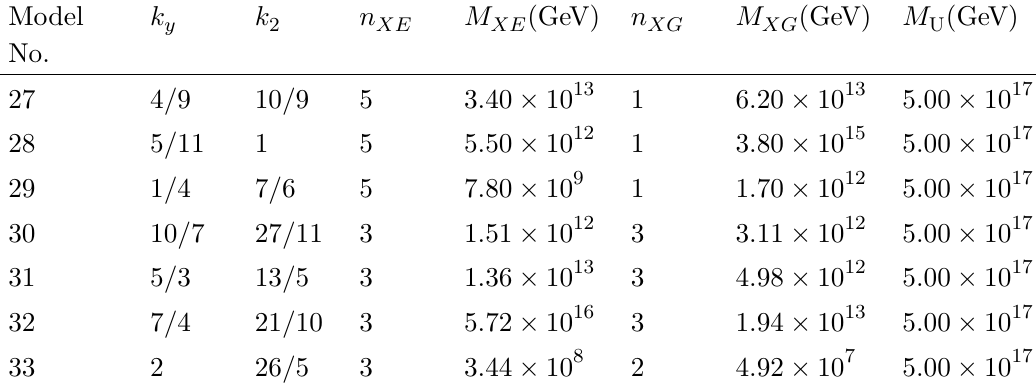
Table 7 . String-scale gauge coupling relations achieved by adding vector-like particles XE + XE from N = 2 subsector and XG from the adjiont sector. The number of XE + XE is defined by the intersection number on a and c stacks, n = I XE ac